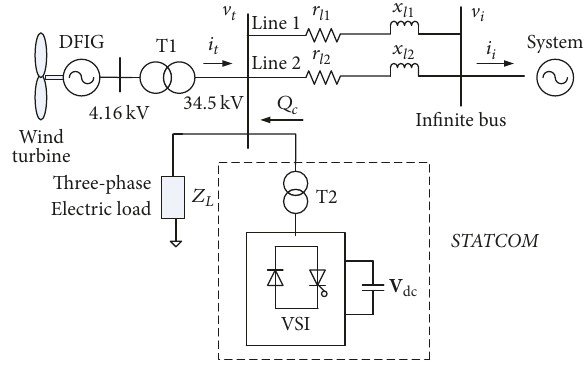
Figure 7: Single line diagram showing STATCOM connection for reactive power compensation